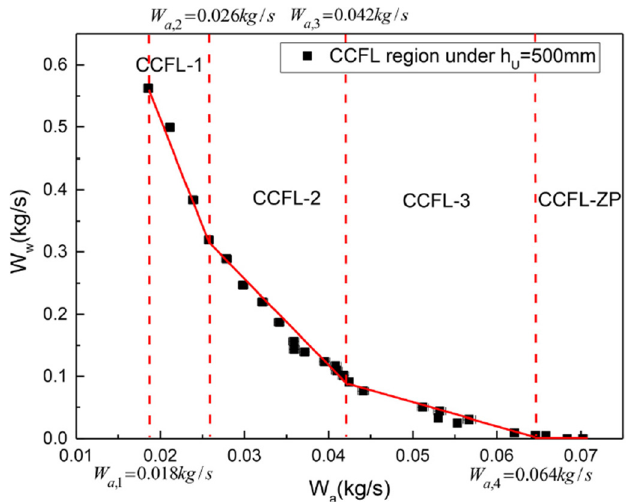
Figure 15. Definition of flooding region (Yu et al.